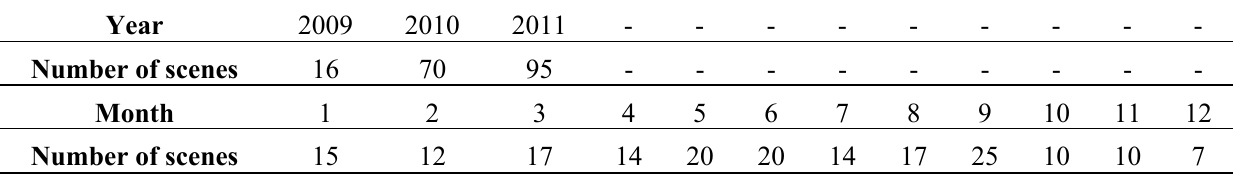
Table 1. Synthetic aperture radar (SAR) data used in the study per year and per